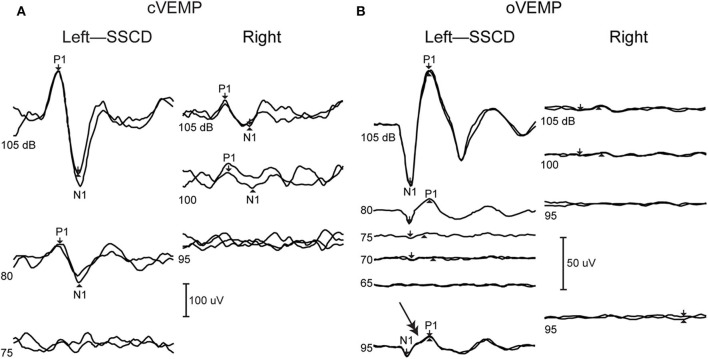
VEMPs from dehiscent (left) and patent (right) ear. (A) cVEMP shows increased amplitudes in the dehiscent ear. (B) oVEMP shows increased amplitudes as well as abnormal response at super high frequency 4,000 Hz (double arrow). Republished from (70), with permission.